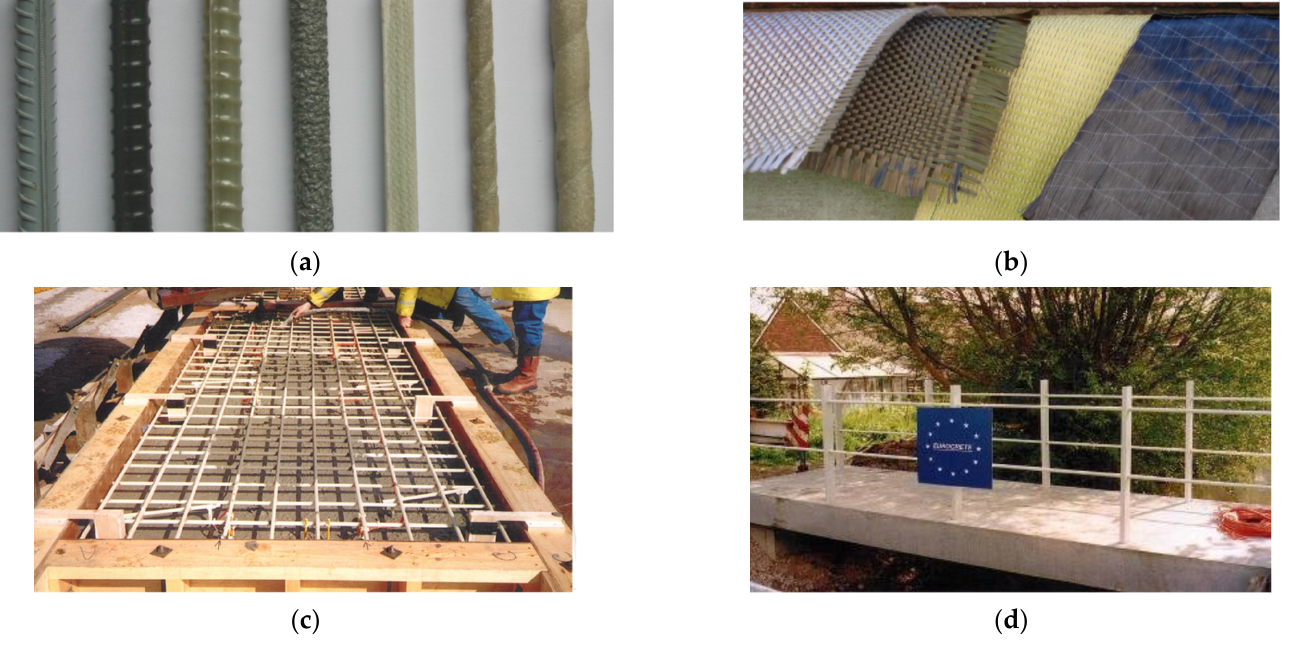
Figure 5. FRP as a reinforcement: ( a ) FRP rebars [48,66]; ( b ) FRP fabrics [66]; ( c ) FRP bars in 1995 Fidgett Footbridge Chalgrove-Oxfordshire, UK [66]; ( d ) Completed Fidgett Footbridge [66].